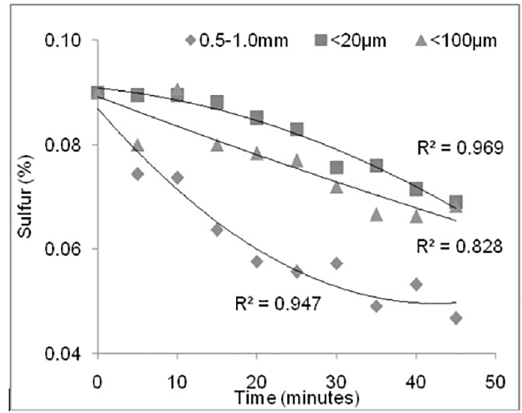
Figure 10. Content of sulfur as a function of time.